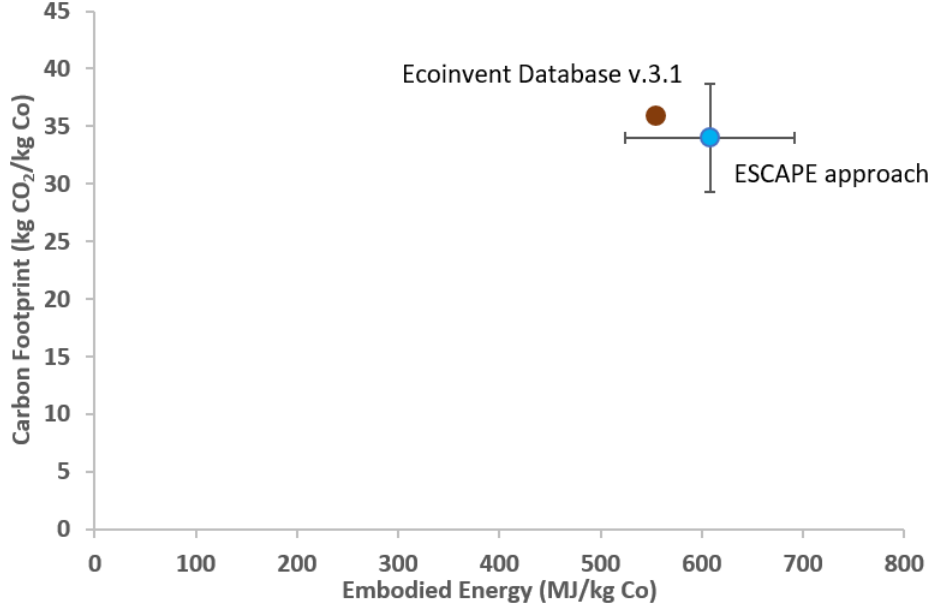
Figure 2. EE and CF of reference process evaluated by Ecoinvent Database and Escape approach for the process presented by Biswas and Bafubiandi [8].